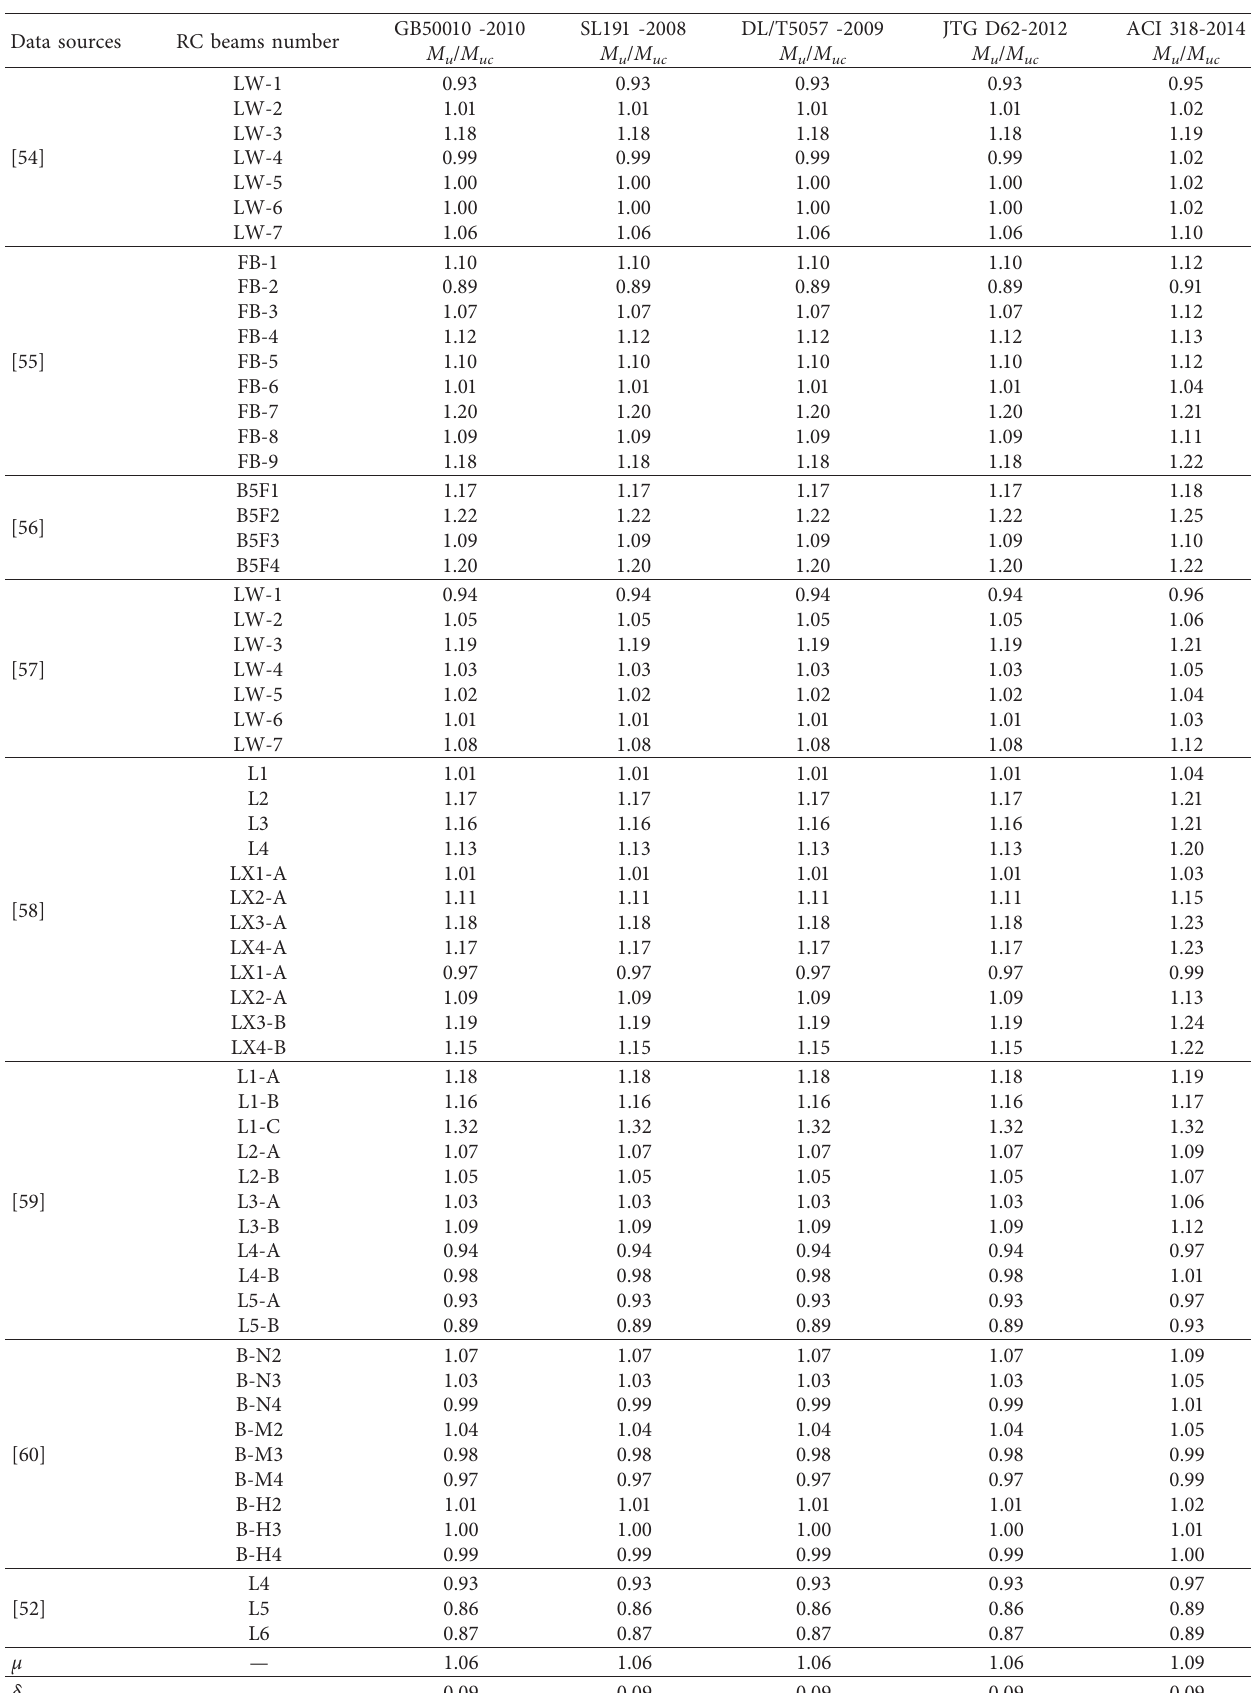
Table 9: Comparison experimental flexural bearing capacity Mu with Muc calculated by different codes for beams with 500 MPa steel bars. Data